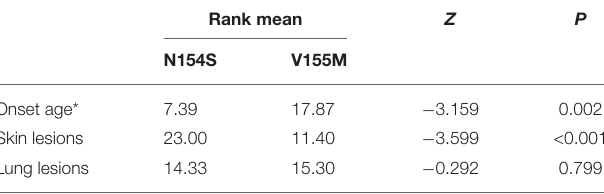
TABLE 5 | Clinical comparison between p.N154S and p.V155M